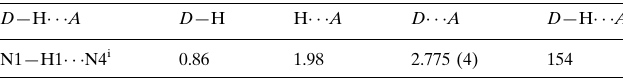
Hydrogen-bond geometry (A˚ , (cid:1)